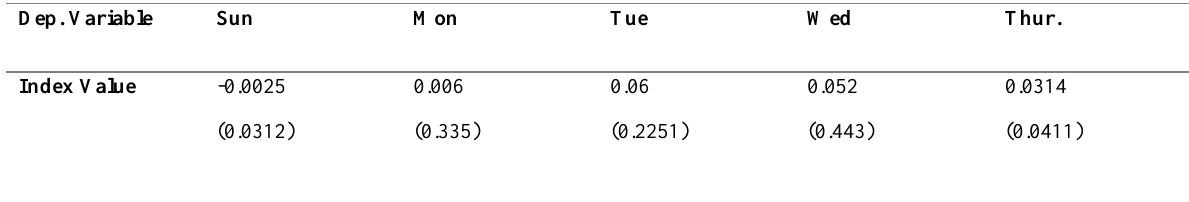
Table 3: Results of Regressing Daily Returns on Week